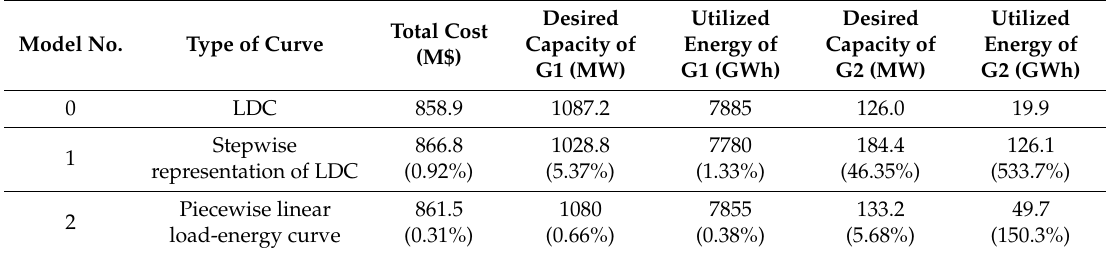
Table 2. Results of the expansion planning